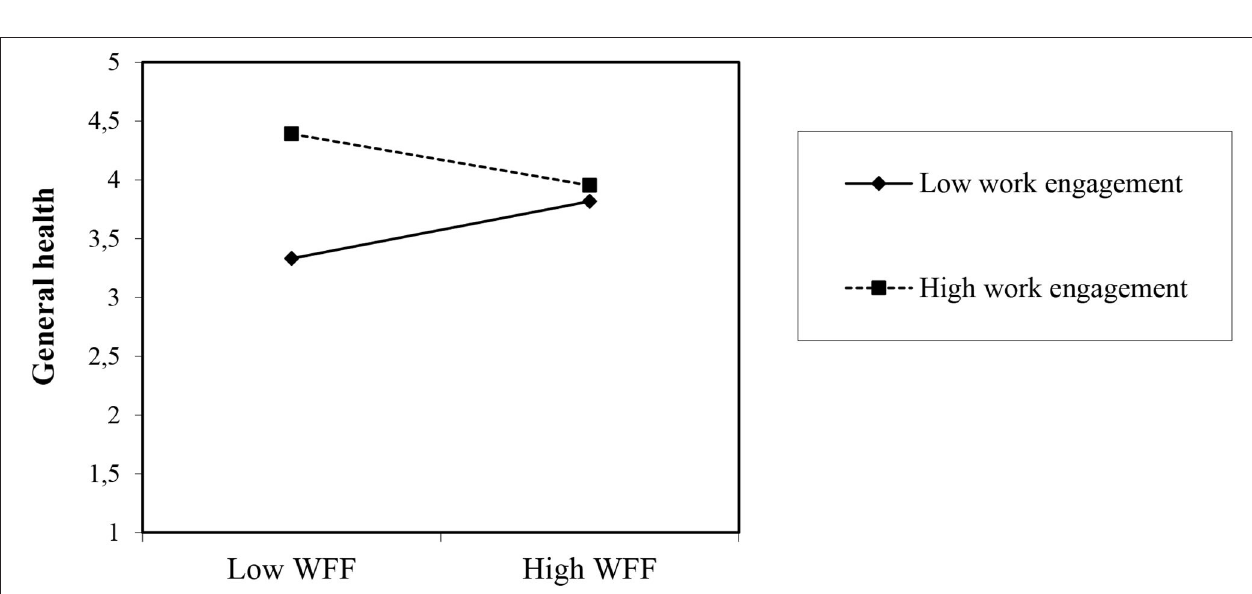
with the positive relation for daily work engagement ( B = 0.30, SE = 0.05; t = 6.36, p < 0.001) and the interaction effect between Figure 4 ) ( B = − 0.46, SE = 0.08; t = − 5.57, p <